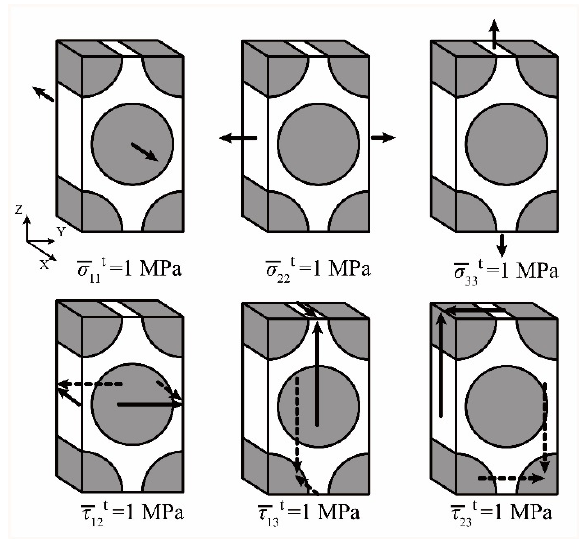
Figure 22. Unit stresses applied on the micro-scale FE model in obtaining the micro-scale stress amplification factors. Table 10. The MMF-based criteria for the micro-scale failure determination.